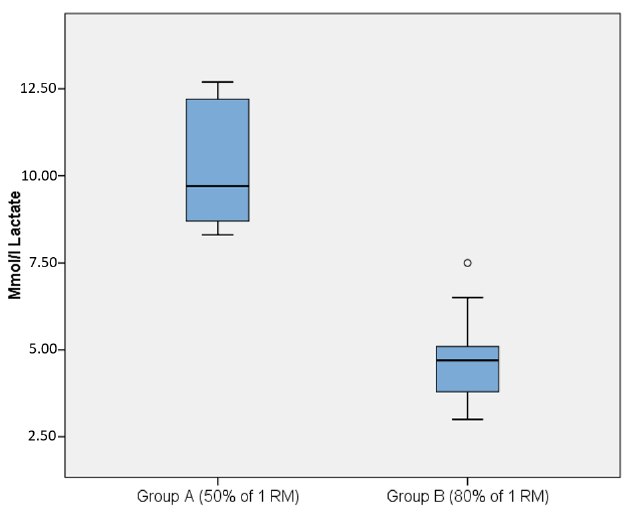
Figure 2. Lactate levels in mmol/l after completed resistance exercise for the group using ( A ) 50% of 1RM and for ( B ) 80% of 1RM. An outlier in Group B (80% of 1RM) is marked with a circle. No significant correlation was shown between lactate levels and experiences in our results. Still, a pattern of negative correlation between lactate levels and participants’ experiences of the resistance exercise session was indicated by a scatterplot (Figure 3).